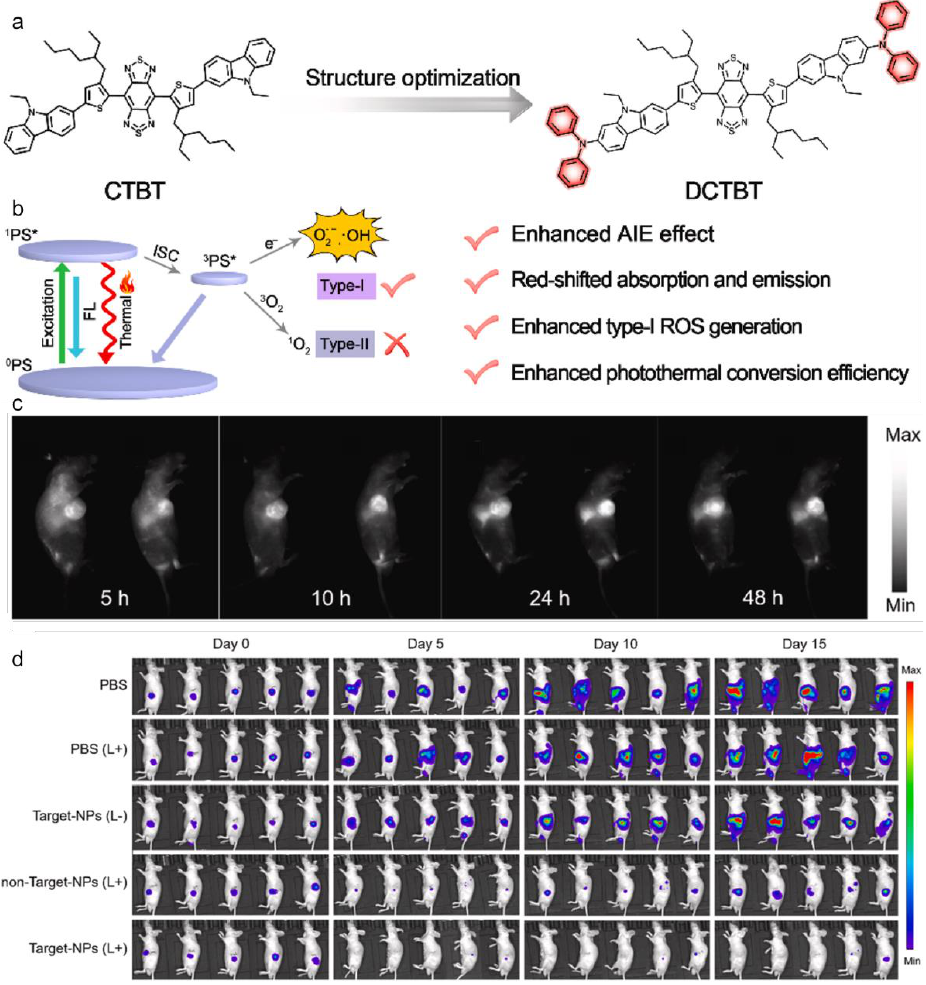
Figure 8. ( a ) Chemical structure modification of DCTBT and ( b ) changes of the related photophysical properties. ( c ) In vivo NIR-II fluorescence imaging of subcutaneous PANC-1 tumor-bearing mice at different time points post intravenous injection. ( d ) Bioluminescence images of orthotopic PANC-